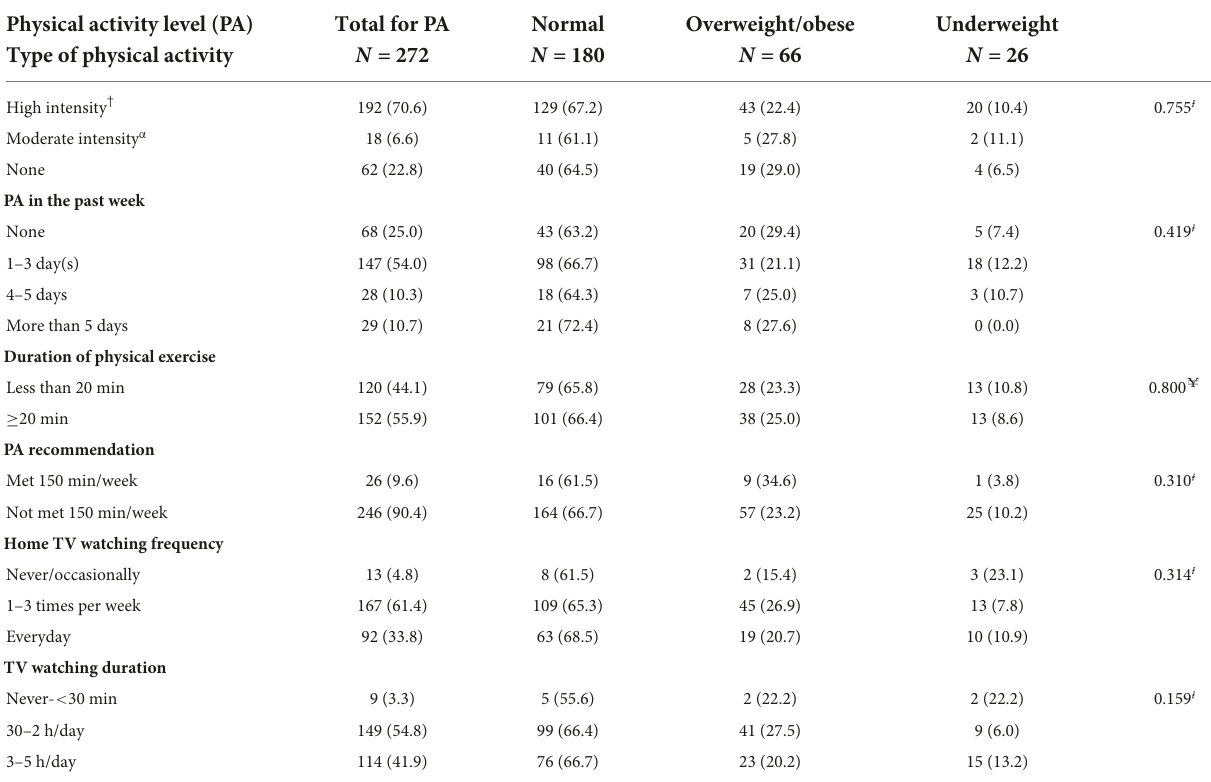
TABLE 2 Physical activity participation and body mass index